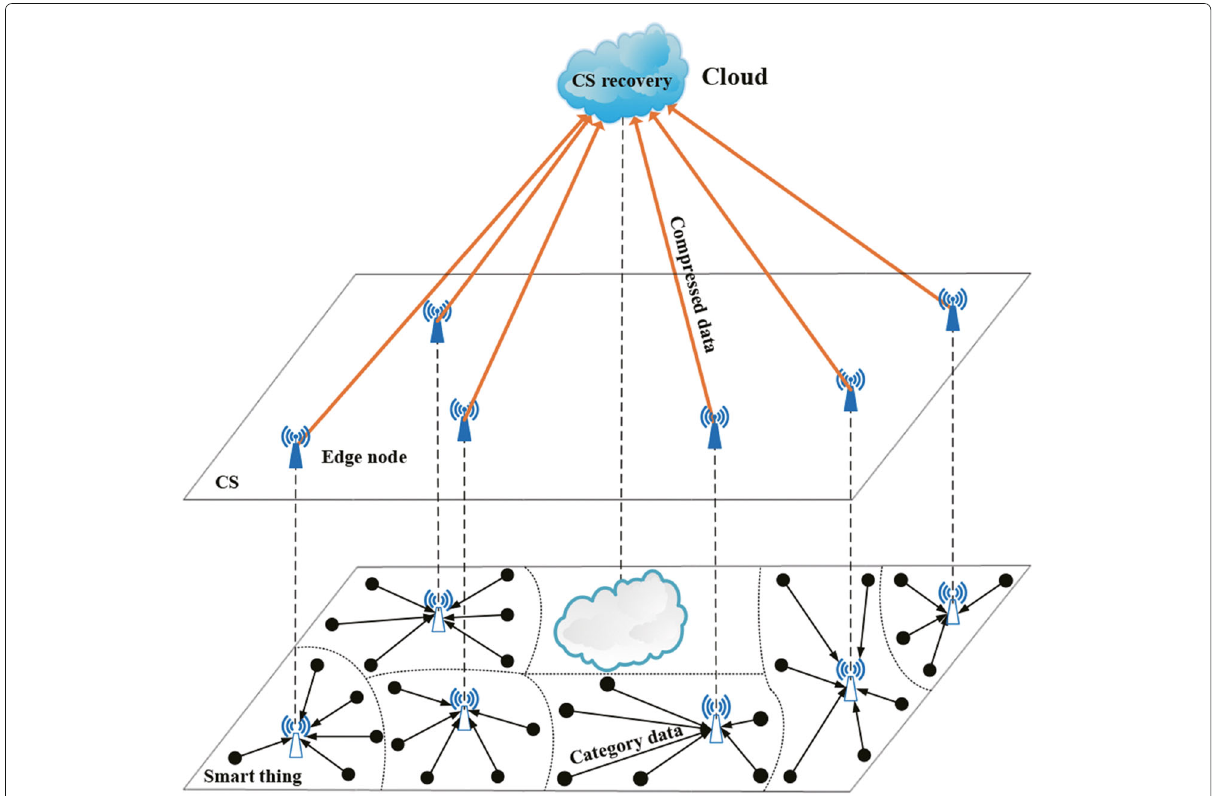
Fig. 1 A Clustered IoT . Black dots represent smart things. Blue towers represent edge nodes. The blue cloud represents a cloud. CS represent category data are compressed by using CS algorithm